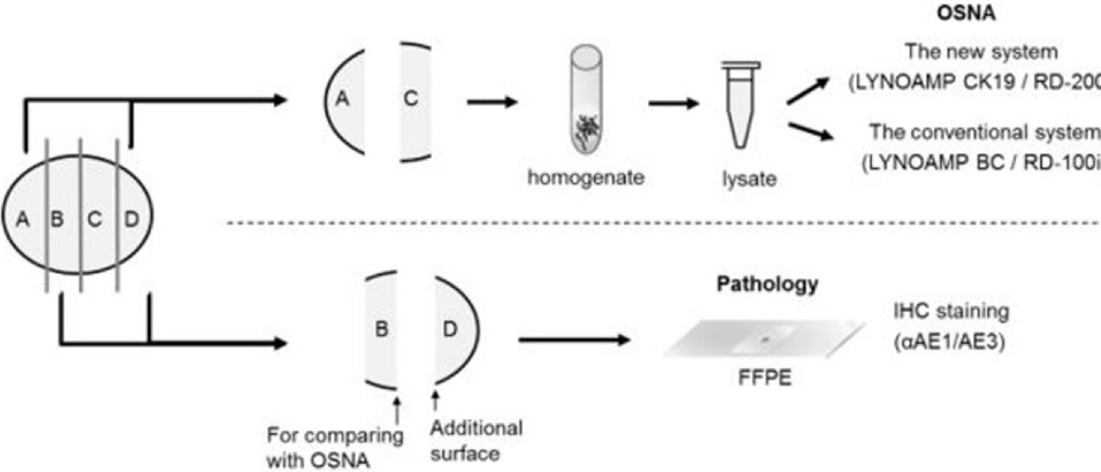
Fig 1. Schematic representation of lymph node preparation. The LN specimens were cut into four pieces. Blocks “A” and “C” were subjected to the OSNA assay, and blocks “B” and “D” were subjected to histopathological analysis with hematoxylin and eosin staining and an IHC assay. OSNA, one-step nucleic acid amplification; IHC, immunohistochemical; FFPE, formalin-fixed paraffin-embedded; AE1/AE3, pan-cytokeratin.